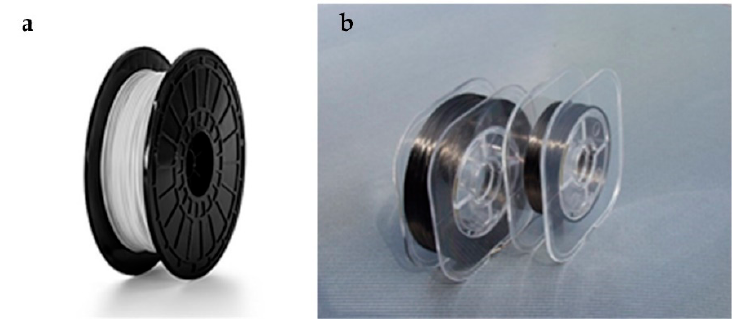
Figure 1. Kossel 3D Printer. ( a ) FlashForge polylactic acid (PLA) 3D filament; ( b ) HTA40 1K carbon fiber.